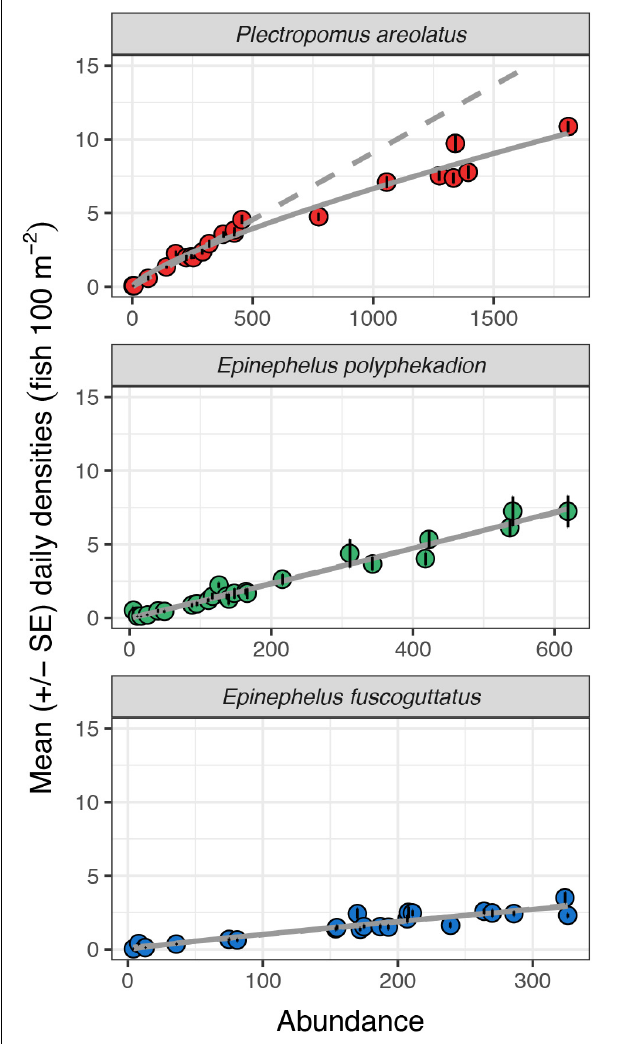
FIGURE 9 | Mean daily densities (fish per 100 m 2 ) and standard errors against total study site UVC abundance values for P. areolatus , E. polyphekadion , and E. fuscoguttatus on all survey days in June, July, August 2009 and June, July 2019. Each point represents the mean of the 20 highest densities recorded during minute counts for each